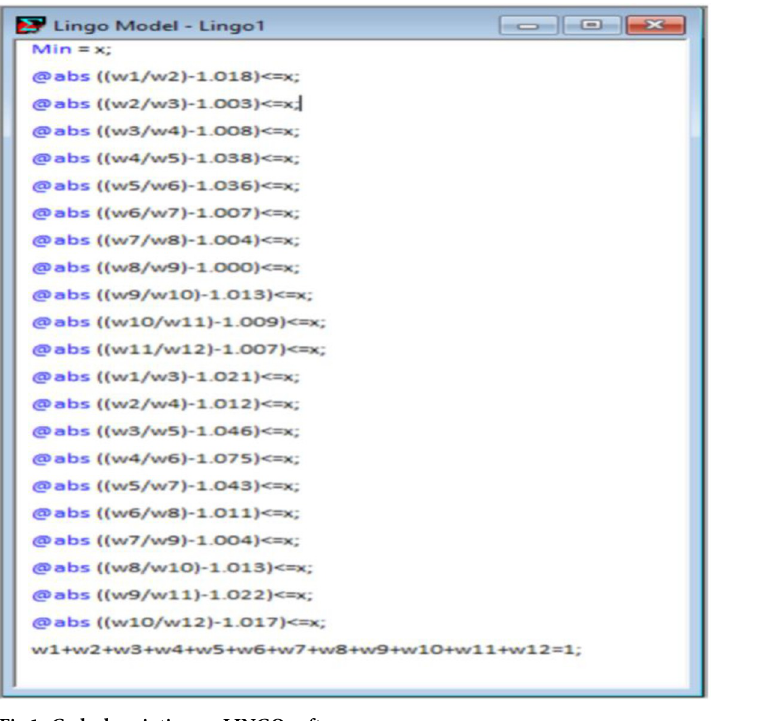
Fig 1. Code description on LINGO